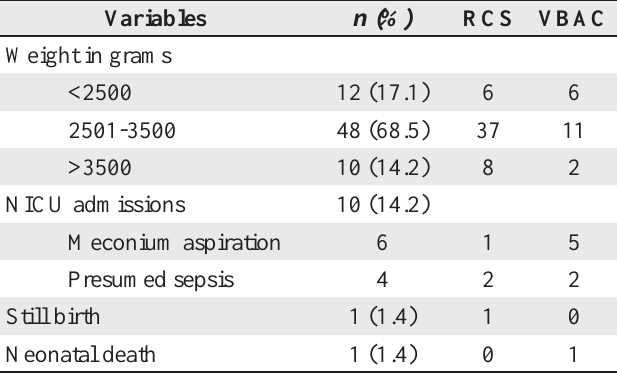
Table 5. Neonatal